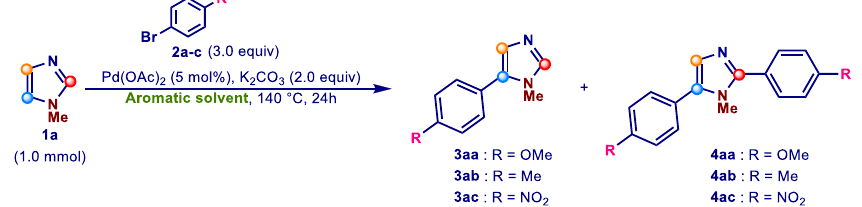
Table 1. Screening of aromatic solvents 1 .